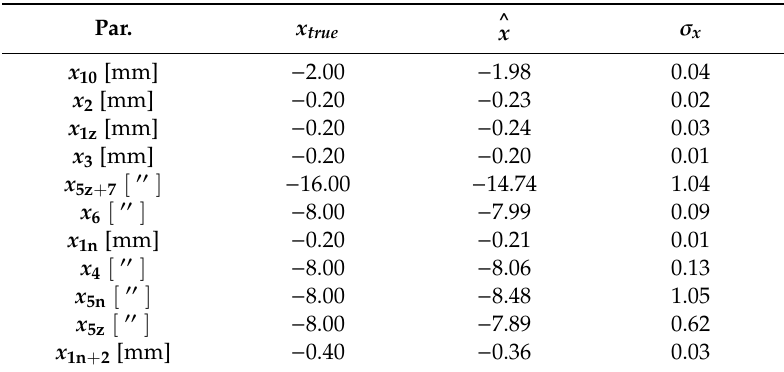
Table 2. The results of the simulation experiment: CP values (simulated and estimated) and standard